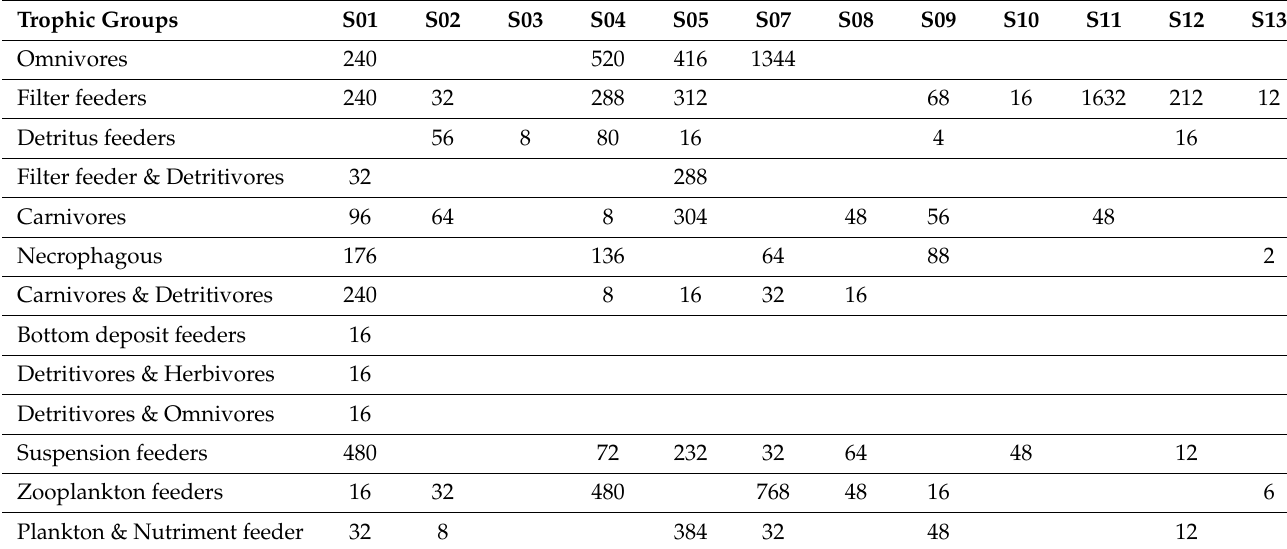
Table 5. Trophic groups of the benthic wildlife found at the 13 sampling locations along the road channel connecting the Ziguinchor maritime port to the